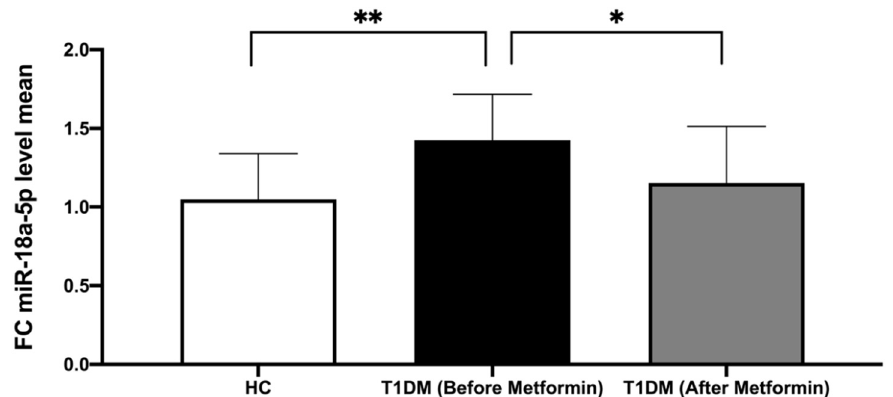
Figure 2. Comparison of miR-18a-5p expression in healthy controls and T1DM patients before and after metformin. Data are presented as means ± SD and the difference between groups is analyzed by t -test; * p < 0.05; ** p < 0.01.